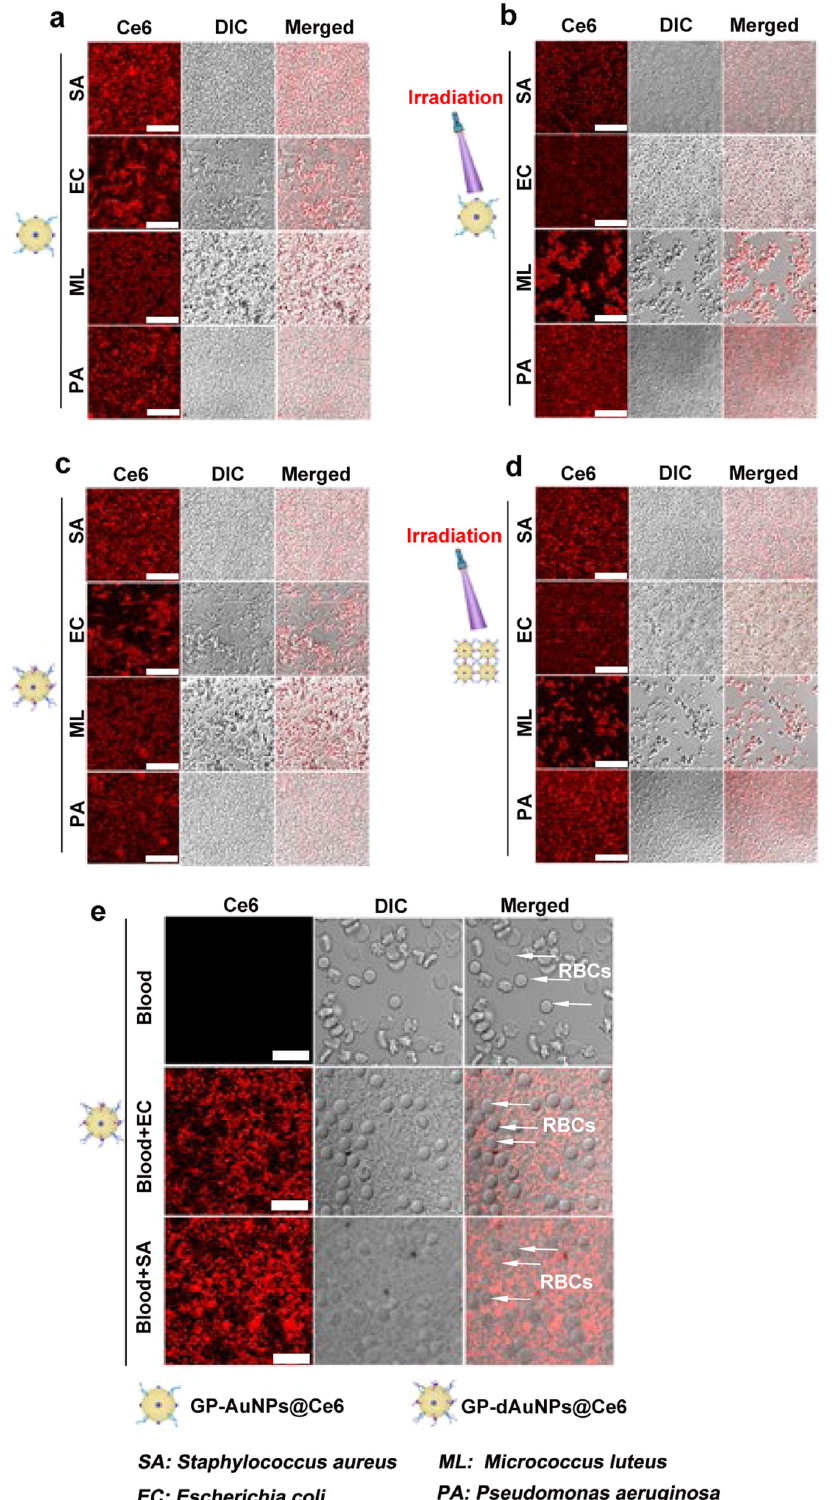
Fig. 3 In vitro imaging of Gram-negative and Gram-positive bacteria based on the proposed strategy. a – d CLSM images of four different kinds of bacteria ( S. aureus (SA), E. coli (EC), M. luteus (ML), P. aeruginosa (PA)) incubated with 1.0 mg mL − 1 GP-AuNPs@Ce6 without ( a ) or with ( b ) 405-nm laser irradiation, or GP-dAuNPs@Ce6 without ( c ) or with ( d ) 405-nm laser irradiation. After incubation, the treated bacteria were rinsed with PBS buffer for several times. The bacterial cell concentration is ~1.0 × 10 7 CFU. Laser power:1.0 W cm − 2 , irradiation time: 25 min. Scale bars, 10 μ m. e Confocal fl uorescence images of pure human blood, the mixture of human blood and EC or SA after incubation with GP-dAuNPs@Ce6. Arrows indicate red blood cells (RBCs). Scale bars: 25 μ m. All imaging experiments were repeated three times with similar